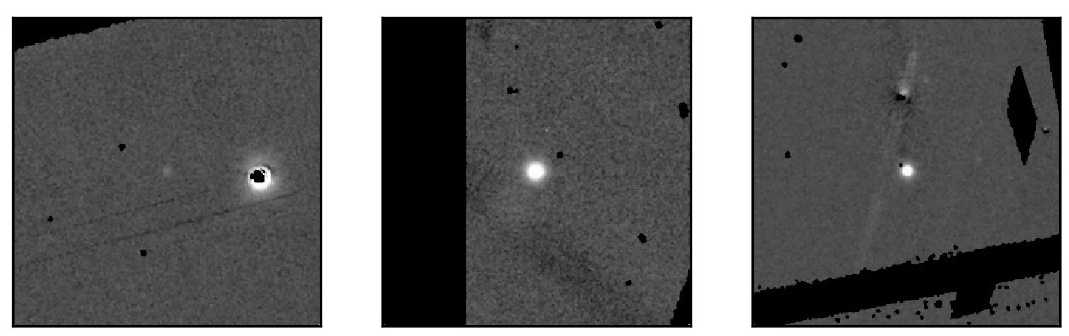
Figure 1. Sample images in the Pan-STARRS1 SuperNova (PS1-SN)